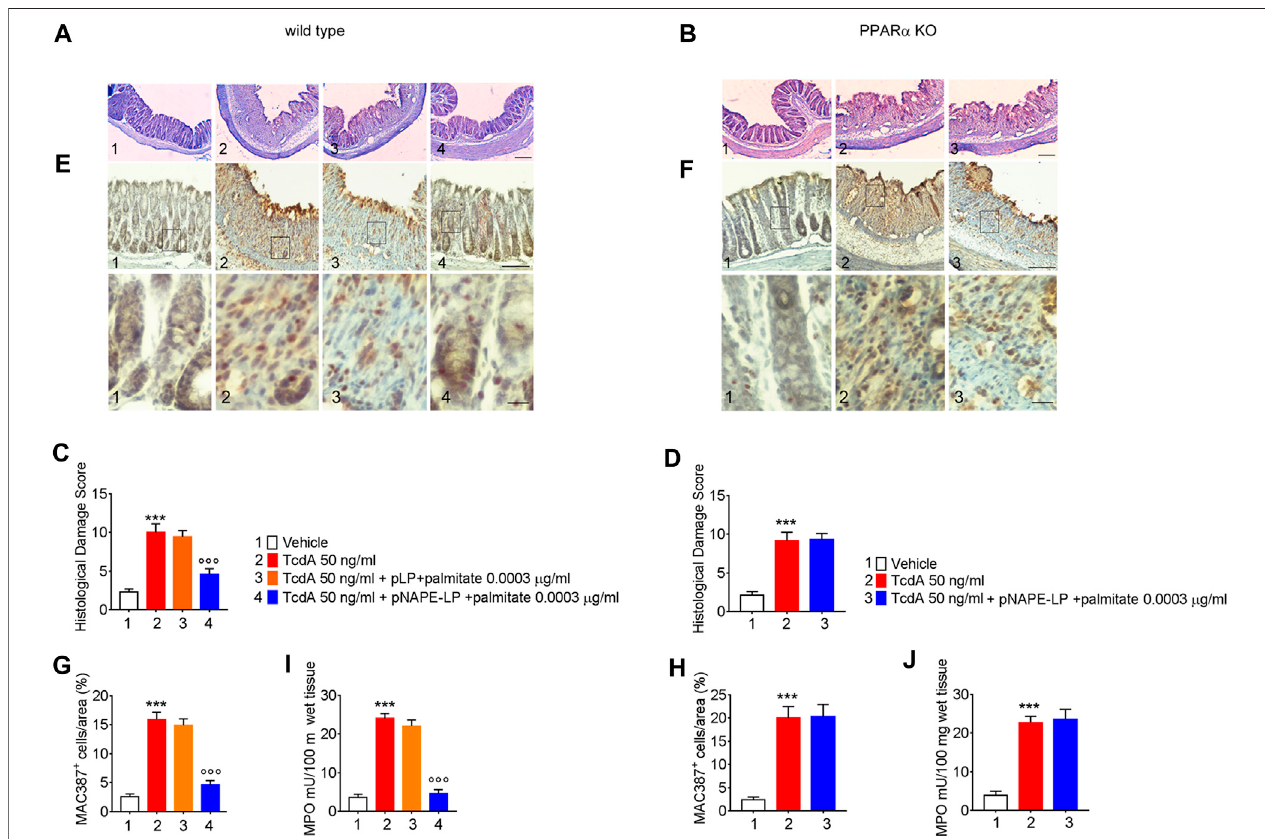
FIGURE3 | Prophylactic administration ofpNAPE-LP and ultralow palmitate dose accountsfor histologicaldamage attenuation with macrophage and neutrophils in fi ltration reduction in TcdA challenged mice. Hematoxylin and eosin (H and E) stained distal colonic specimens and (A, B) relative histological damage score showing the protective and PPAR α -dependent effect of pNAPE-LP/palmitate treatment on TcdA-induced colonic injury (C, D) in both wild type and PPAR α mice (magni fi cation 4 × , scale bar: 100 μ m). Figure also shows the effect of pNAPE-LP/palmitate association on the immunohistochemical expression of MAC387 positive cell (marker ofmacrophagedensity) indistal colonicsections derivingfrom wildtype andPPAR α KO mice (E,F) (magni fi cation 10 × and 40 × ,scalebar:100and 50 μ m,respectively) and its relative quanti fi cation (G, H) , and the myeloperoxidase (MPO) activity quanti fi cation (indirect evidence of neutrophils in fi ltration) in both mice types (J, K) . Results are expressed as mean ± SEM of n (cid:2) 5 experiments. *** p < 0.001 vs. vehicle; ooo p < 0.001 vs. TcdA-treated mice.